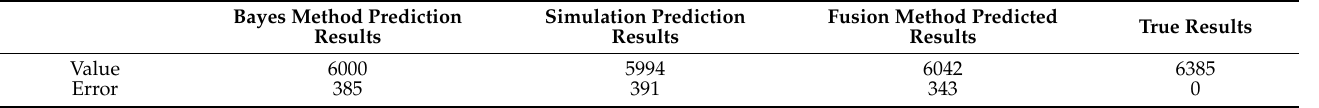
Table 3. Life reliability prediction results.